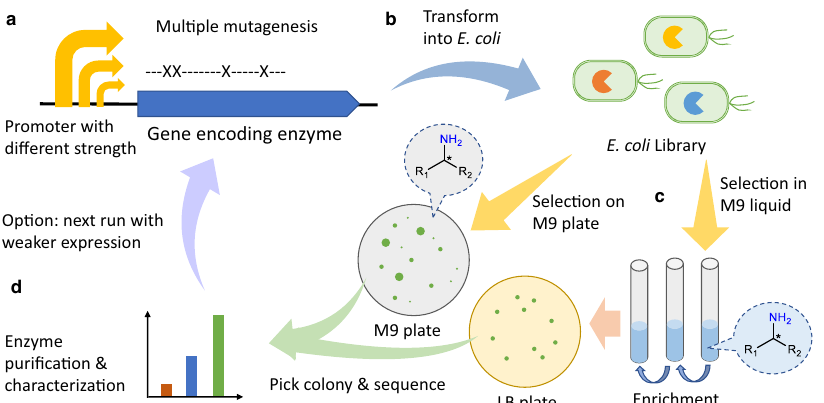
orliquidmediumwiththetargetedamineastheonlynitrogensource. d Isolationof single colonies, sequencing of the genes, and characterization of the enzyme variants.